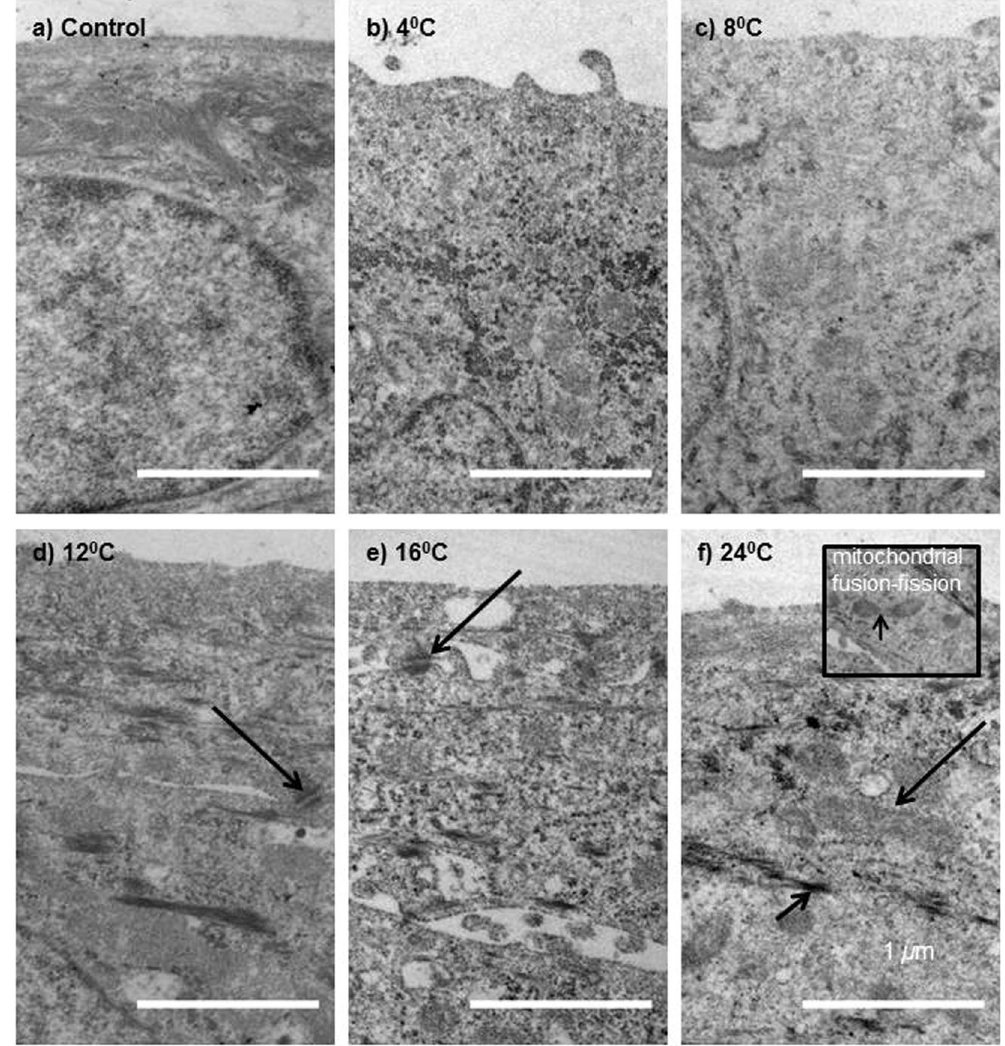
Figure 5. Cell morphology as shown by transmission electron microscopy (X24500) micrographs. Normal desmosome connections between cells (arrows) were seen at all temperatures, represented in ( e ) and ( f ). Large mitochondria (arrow) were more frequent at 24 °C ( f ). Mitochondrial fission or fusion (arrow) was also seen at 24 °C (inset ( f )). Keratin bundles (arrowhead) were visible at all temperatures, but were more pronounced at 24 °C ( f